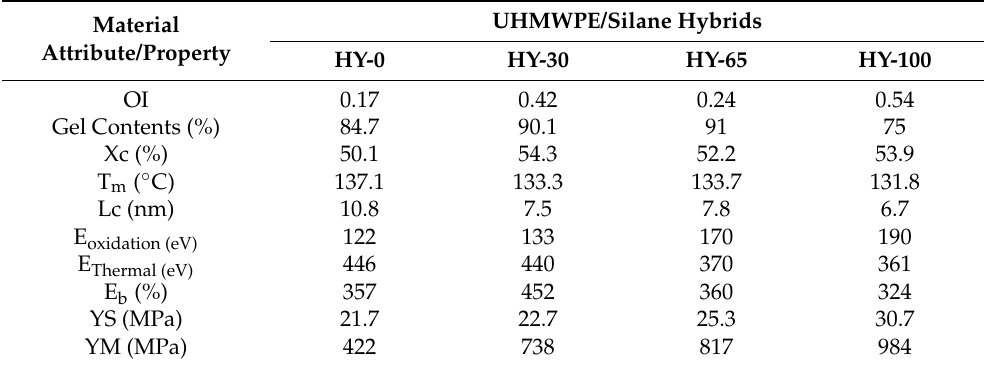
Table 1. Measured values of selected attributes/properties for establishing structural–property optimization and ranking of hybrids.